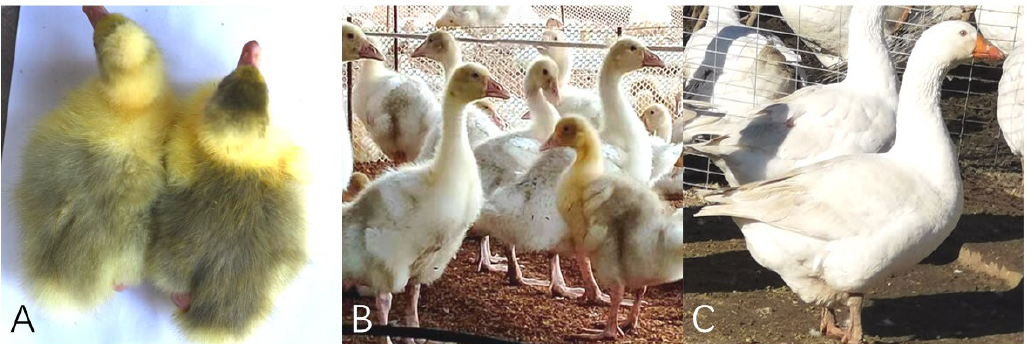
Figure 1. Color change process of Holdobaggy geese in different growth stages. Note that ( A ) is the gosling’s newborn (1–2 days old) with black and gray feathers on their backs and some heads; ( B ) is the young goslings aged 4–6 weeks in the molting stage with white feathers on their backs; ( C ) is the adult geese with white feathers on their whole body.